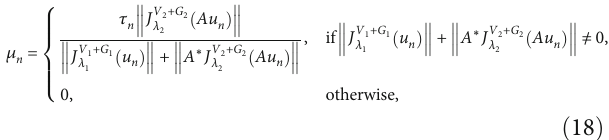
Algorithm 2. For an arbitrary x 0 , compute the n + 1 th